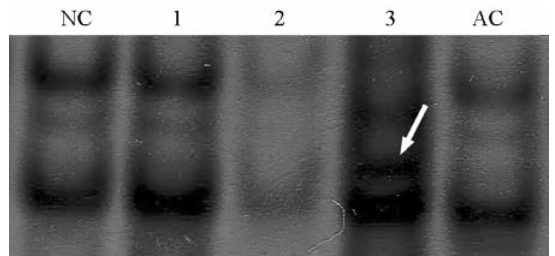
Figure 3 - PCR/SSCP analysis of exon 5 of the TP53 gene. NC - normal control,lanes1and2-cases1and2,showingthenormalpatternofmigra- tion; Case 3 - 3, showing the abnormal mobility shift; AC - abnormal con-